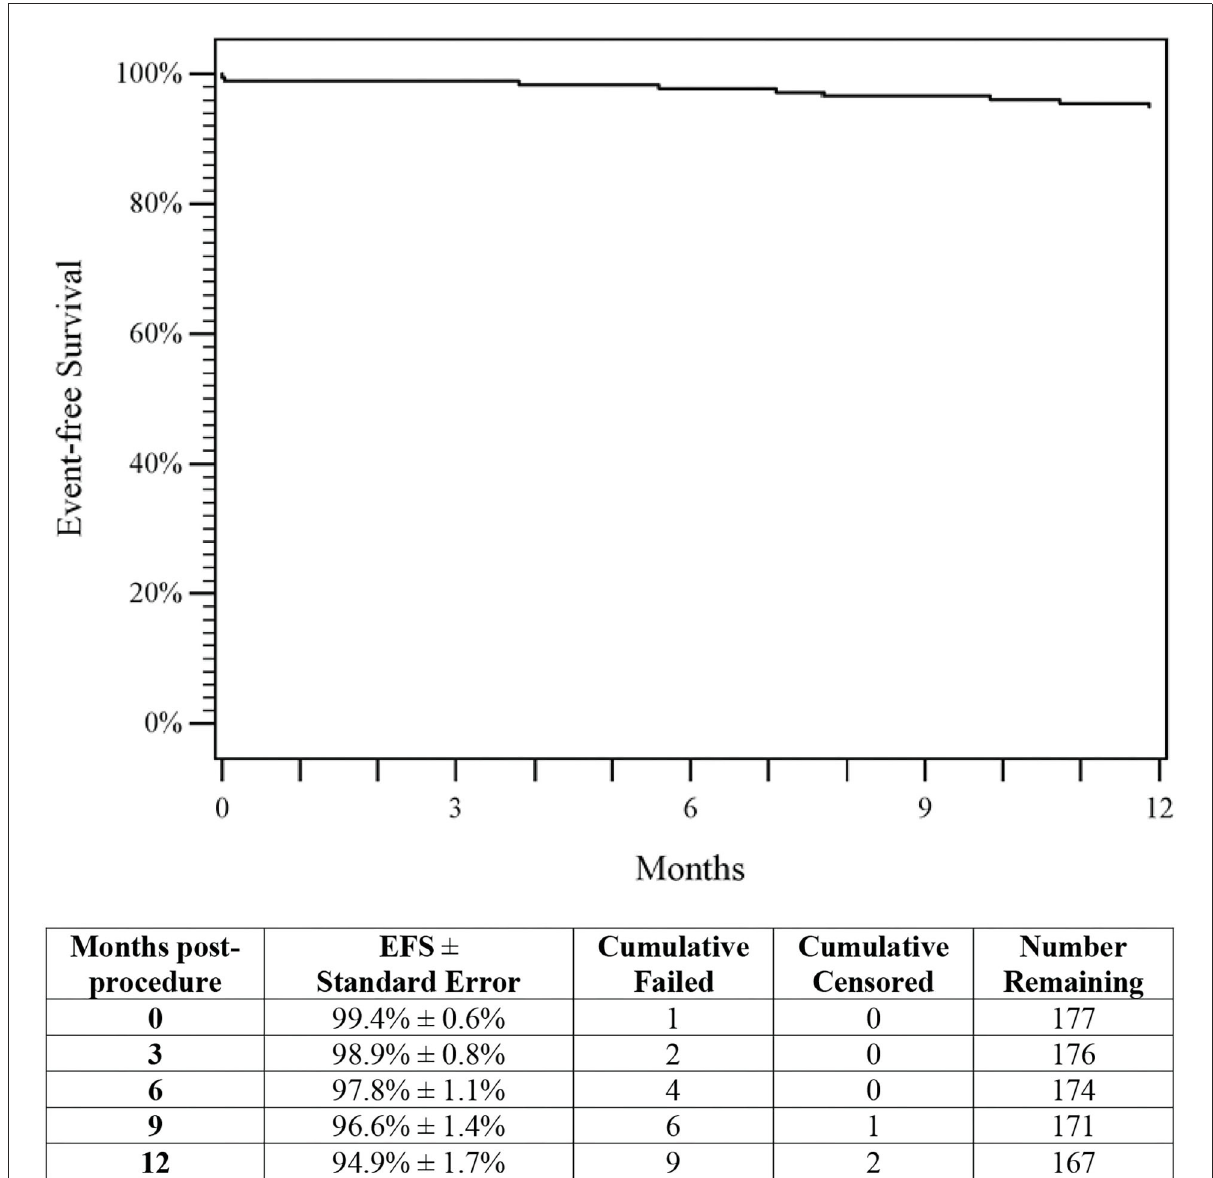
FIGURE3 Event-free survival. The Kaplan–Meier curve shows a 94.9% rate of event-free survival (EFS) through 1-year for patients treated with DES. The life table is included. DES, drug-eluting stent; EFS, event-free